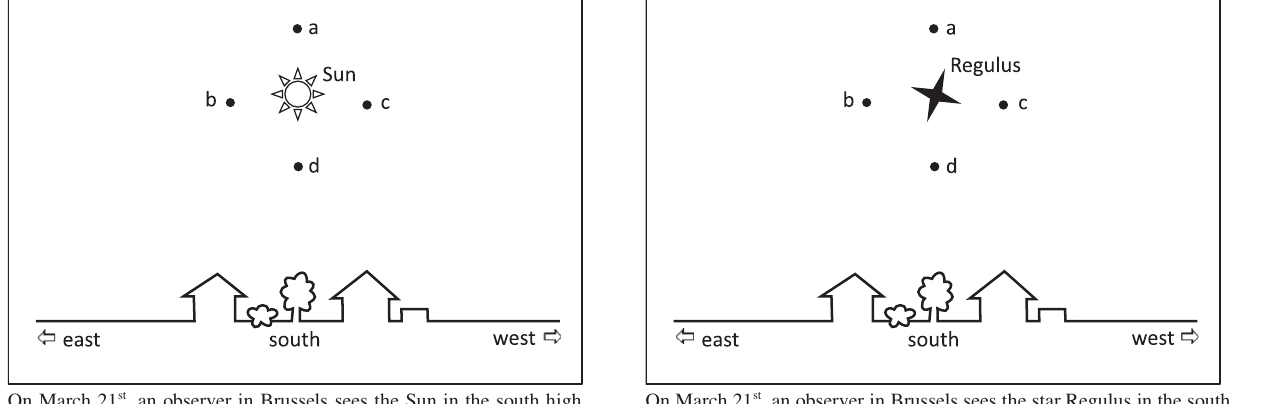
FIG. 1. The Sun and star question of category A are formulated as isomorphic as possible. See the Supplemental Material [52] for the complete version of the AMoSS test.